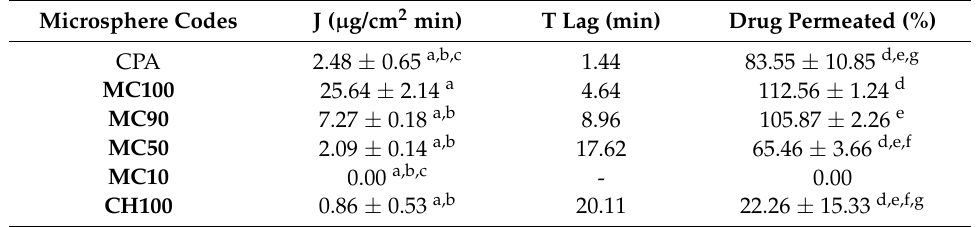
Figure 5. The permeation profiles of N6-cyclopentyladenosine (CPA) from formulations through lipophilic membranes. Profiles are compared with those of the raw drug. Data are reported as the mean ± standard deviation (SD) of three independent experiments. Table 2. Values of flux (J), T lag and drug permeated for each formulation after 120